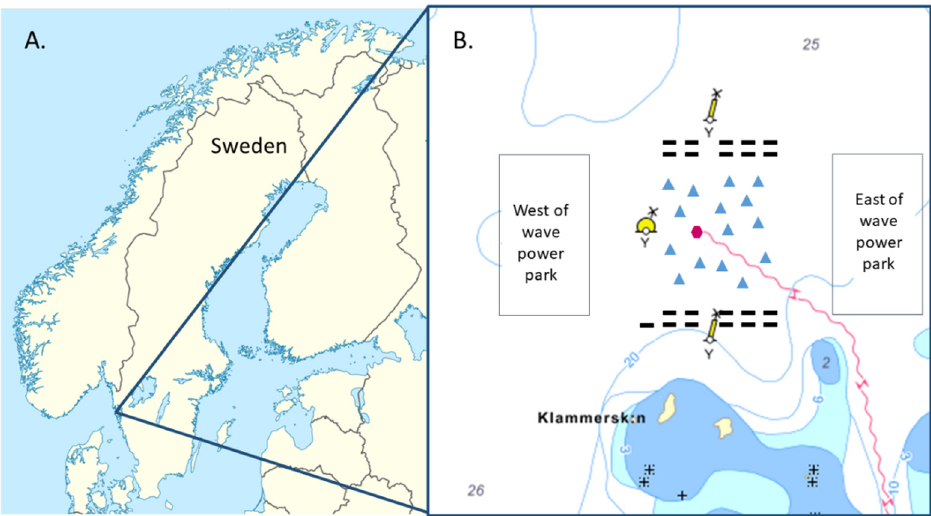
Figure 1. ( A ) Location of the Lysekil research site on the Swedish west coast. ( B ) Sea chart of the wave power park, marked with two yellow rod-shaped sea markings. The yellow buoy between the two rod-shaped sea markings indicates the position of the wave-measuring buoy. The red line indicates the position of a sea cable. Blue triangles mark the position of generators, black rectangles mark ecological foundations, and the red hexagon indicates the position of the marine substation. Sampling locations east and west of the wave power park are marked as squares. Numbers indicate water depth and light-yellow areas represent islands. Note: size and position of symbols are not to scale.